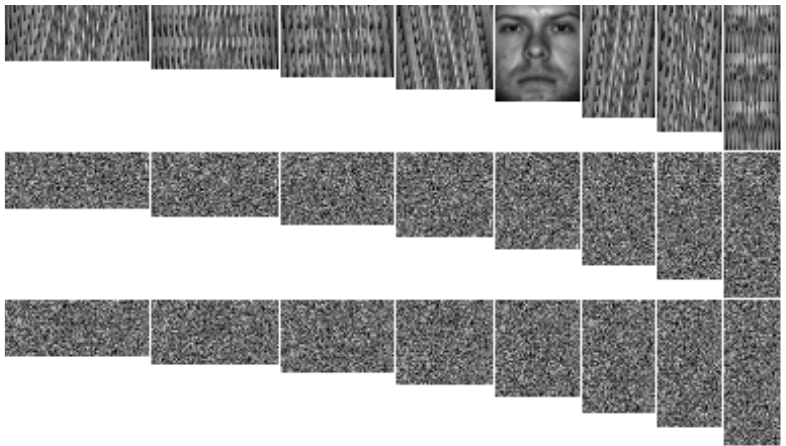
Figure 4. The reordered and reshaped images of a sample image from the Extended Yale B face database. The original image is shown in the fifth column of the first row. The other two images in the fifth column are two randomly reordered variants of this image. In each row, the remaining images are generated by reshaping the fifth image of that